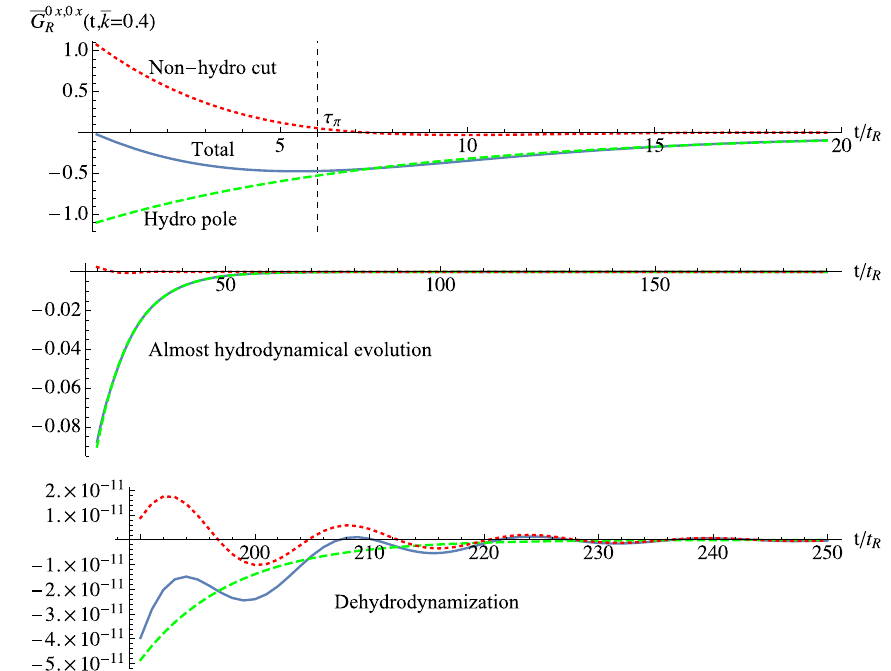
Fig. 11 The full physical ( t , ¯ k ) as a response ¯ G 0 x , 0 x R function of time for ¯ k = 0 . 4 (blue line) and the individual pole (green dashed line) and cut (red dotted line) contributions ( t , k ) that determine G 0 x , 0 x R according to Eq. (65). The dashed vertical line indicates the time-scale τ π = 6 t R where hydrodynamization is estimated to be accomplished, see Eq.